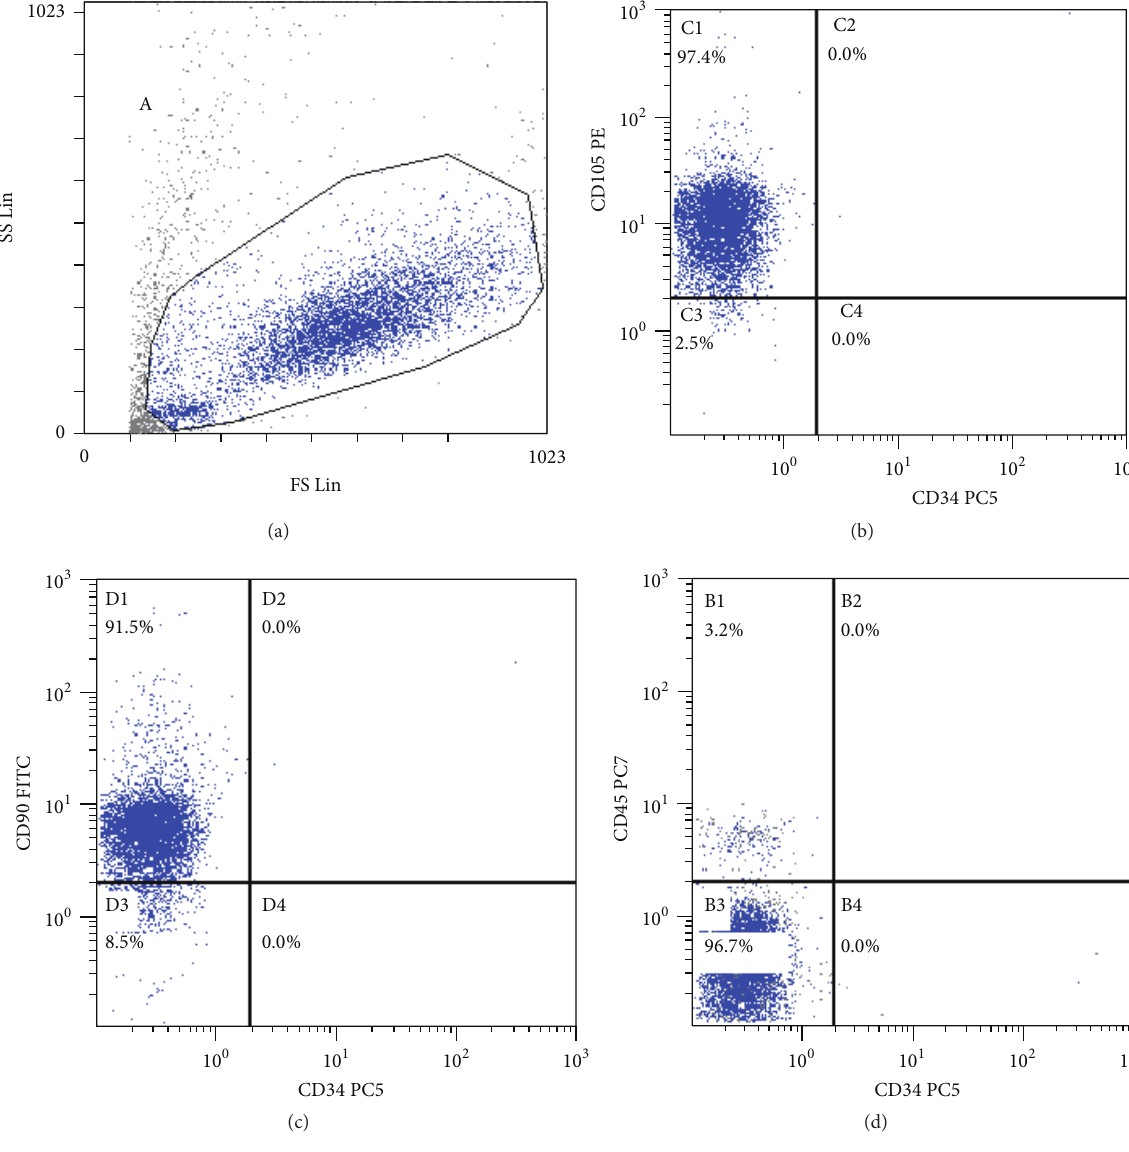
Figure 1: Determination of ASCs phenotype. Membrane antigen expressions of CD45, CD34, CD90, and CD105 on ASCs were analyzed by FACS analysis. As negative markers, CD45 (common lymphocytes antigen) and CD34, an hematopoietic stem cell marker, were shown to be low